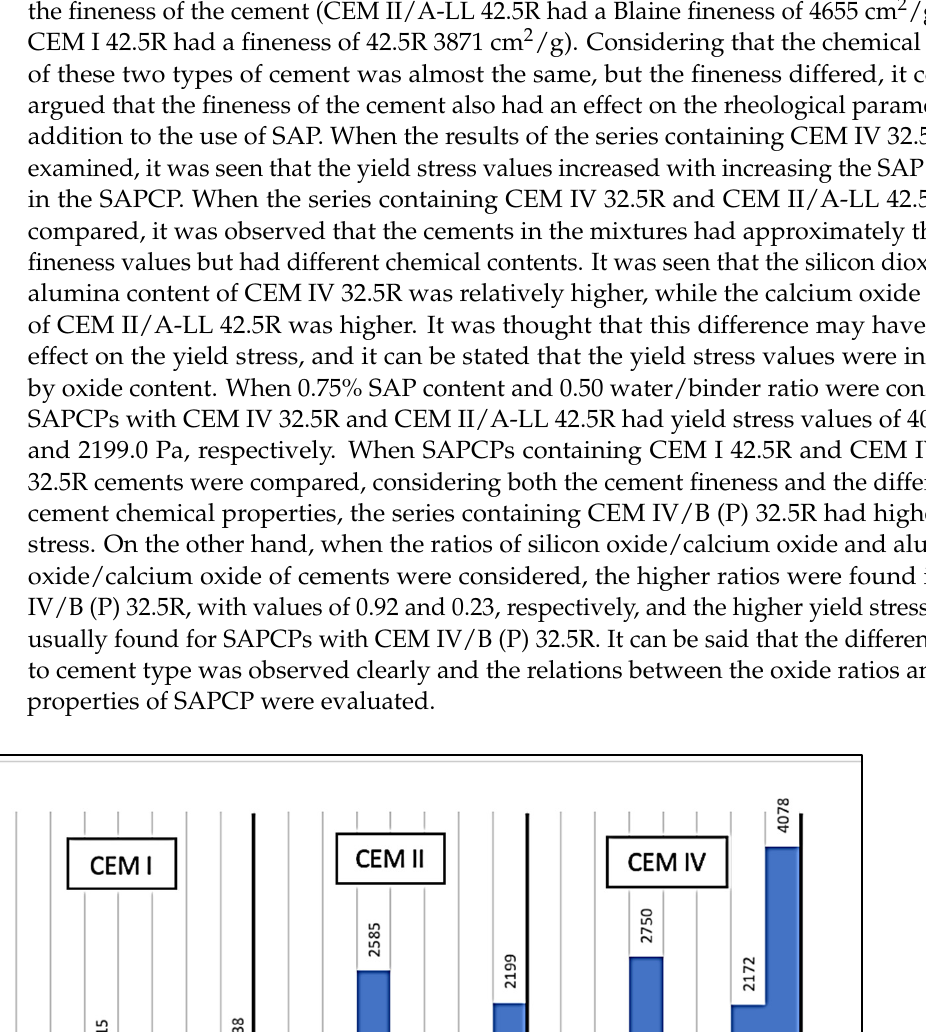
Figure 8. Bingham model [11].